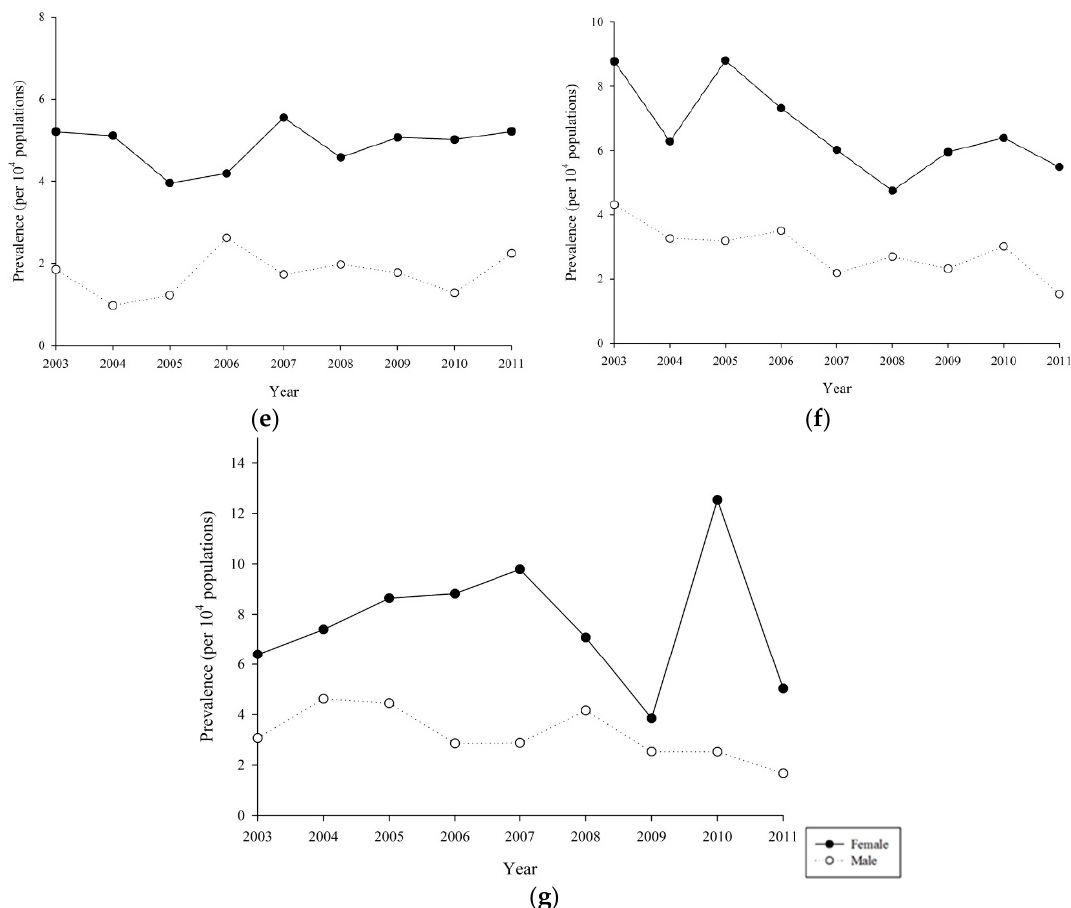
Figure 2. Incidence rate of Rheumatoid Arthritis from 2001 to 2011 by age groups: ( a ) 10–19 years old; ( b ) 20–29 years old; ( c ) 30–39 years old; ( d ) 40–49 years old; ( e ) 50–59 years old; ( f ) 60–69 years old; and ( g ) 70–79 years